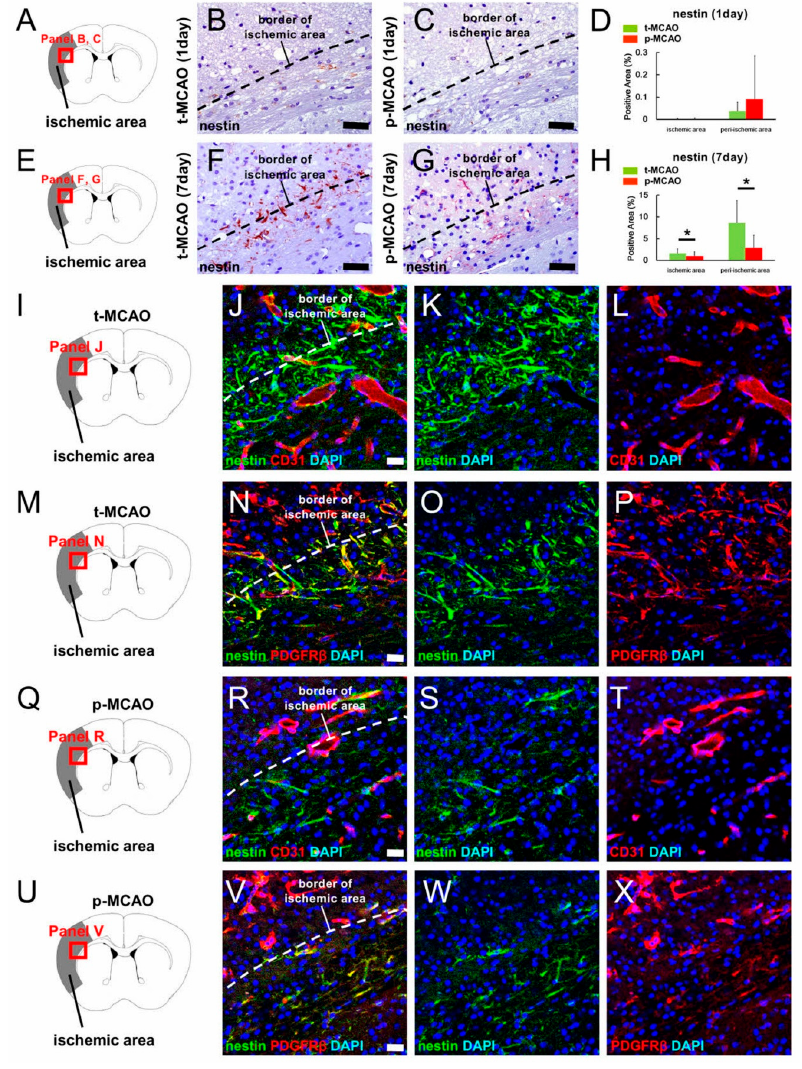
Figure 4. Immunohistochemistry for nestin at 1 d ( A – C ) and 7 d ( E – G ) after 90-min t-MCAO ( B , F ) or p-MCAO ( C , G ). At 1 d post stroke, nestin + areas were not significantly different between the stroke models within the ischemic and peri-ischemic areas ( D ), but were significantly larger in both regions 7 d after 90-min t-MCAO compared to p-MCAO ( H ). Immunohistochemistry at 7 d after 90-min t-MCAO ( I – P ) or p-MCAO ( Q – X ) showed that some nestin + cells within ischemic and peri-ischemic areas localized near CD31 + endothelial cells [90-min t-MCAO, nestin ( J and K : green), CD31 ( J and L : red), DAPI ( J – L : blue); p-MCAO, nestin ( R and S : green), CD31 ( R and T : red), DAPI ( R – T : blue)] and co-expressed PDGFR β [90-min t-MCAO, nestin ( N and O : green), PDGFR β ( N and P : red), DAPI